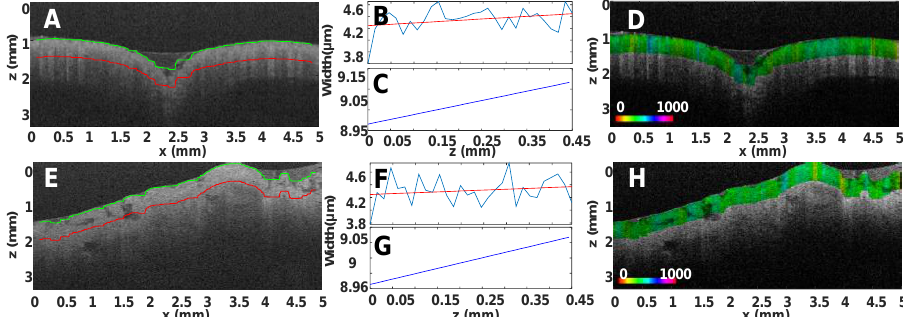
Figure 8. ( A ) OCT image of normal colon tissue (green line: top surface, red line: 0.5 mm depth). ( B ) Mean width as a function of depth for ( A ). ( C ) Degraded Gaussian width as a function of depth calculated from ( B ). ( D ) Overlay of the OCT image (gray scale) and the GVD for each A-Scan in a pseudo-color hue scale. ( E – H ) The same as before for colon adenocarcinoma [136].